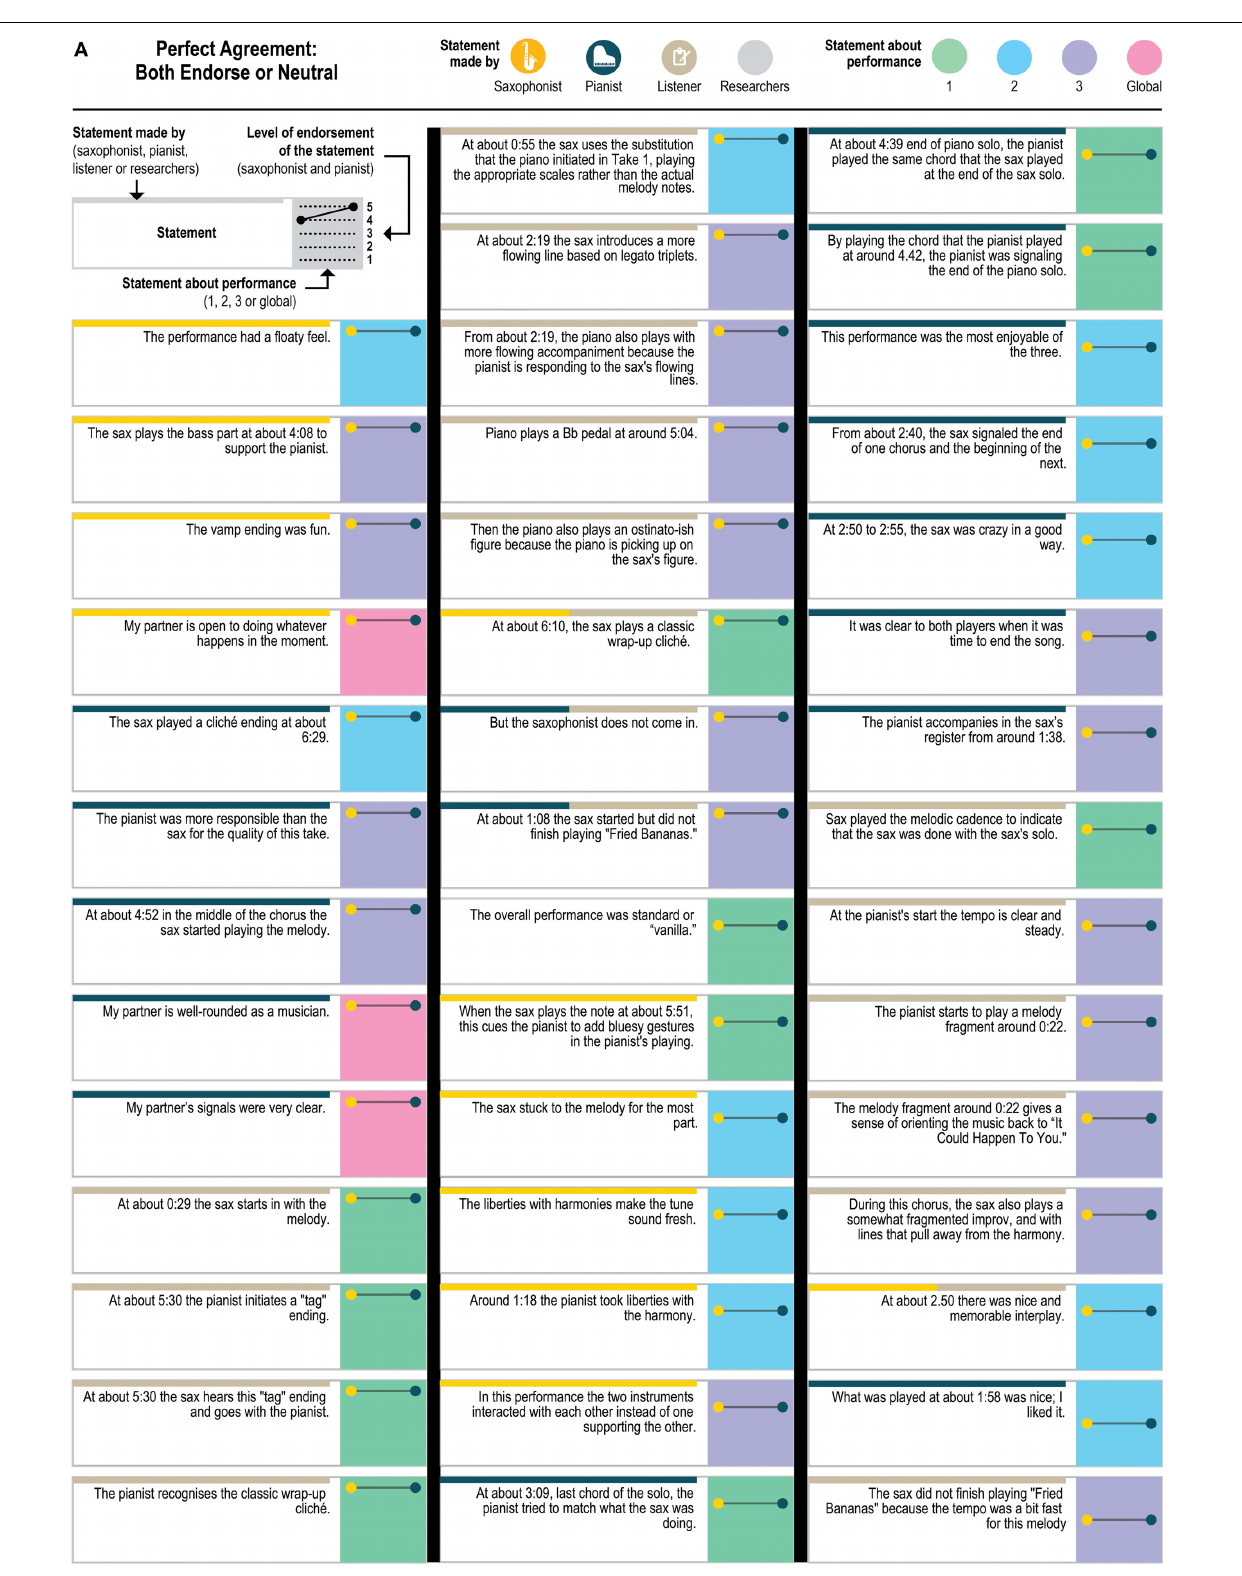
FIGURE 5A | Statements with perfect agreement where both players endorsed the statement or were neutral.